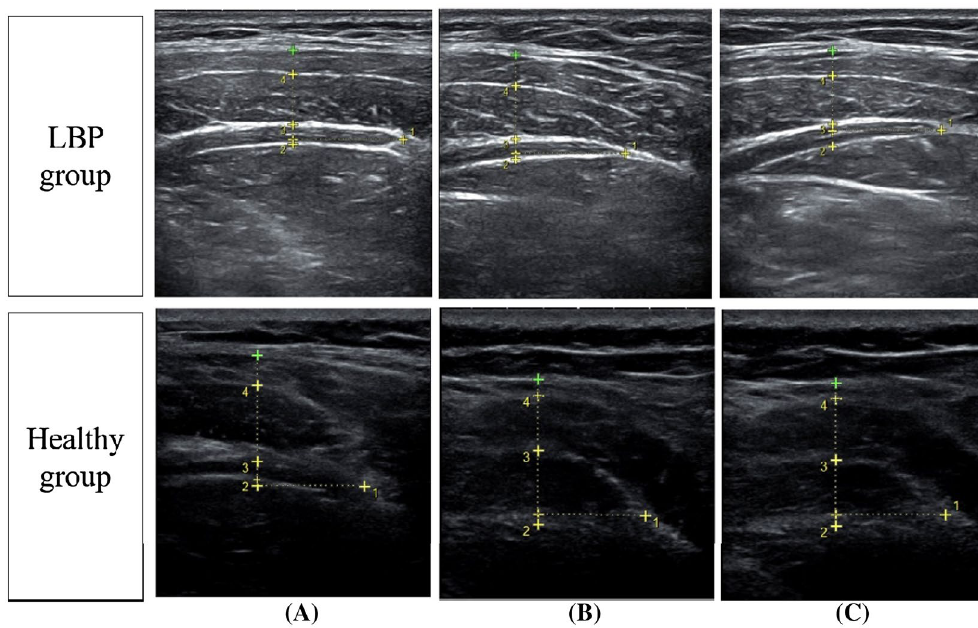
Figure 1. Measurement of the thickness of the transverse abdominis, external oblique, and internal oblique muscles using ultrasonography in the ( A ) supine, ( B ) usual sitting, and ( C ) upright sitting positions, in lower back pain (LBP) group and healthy